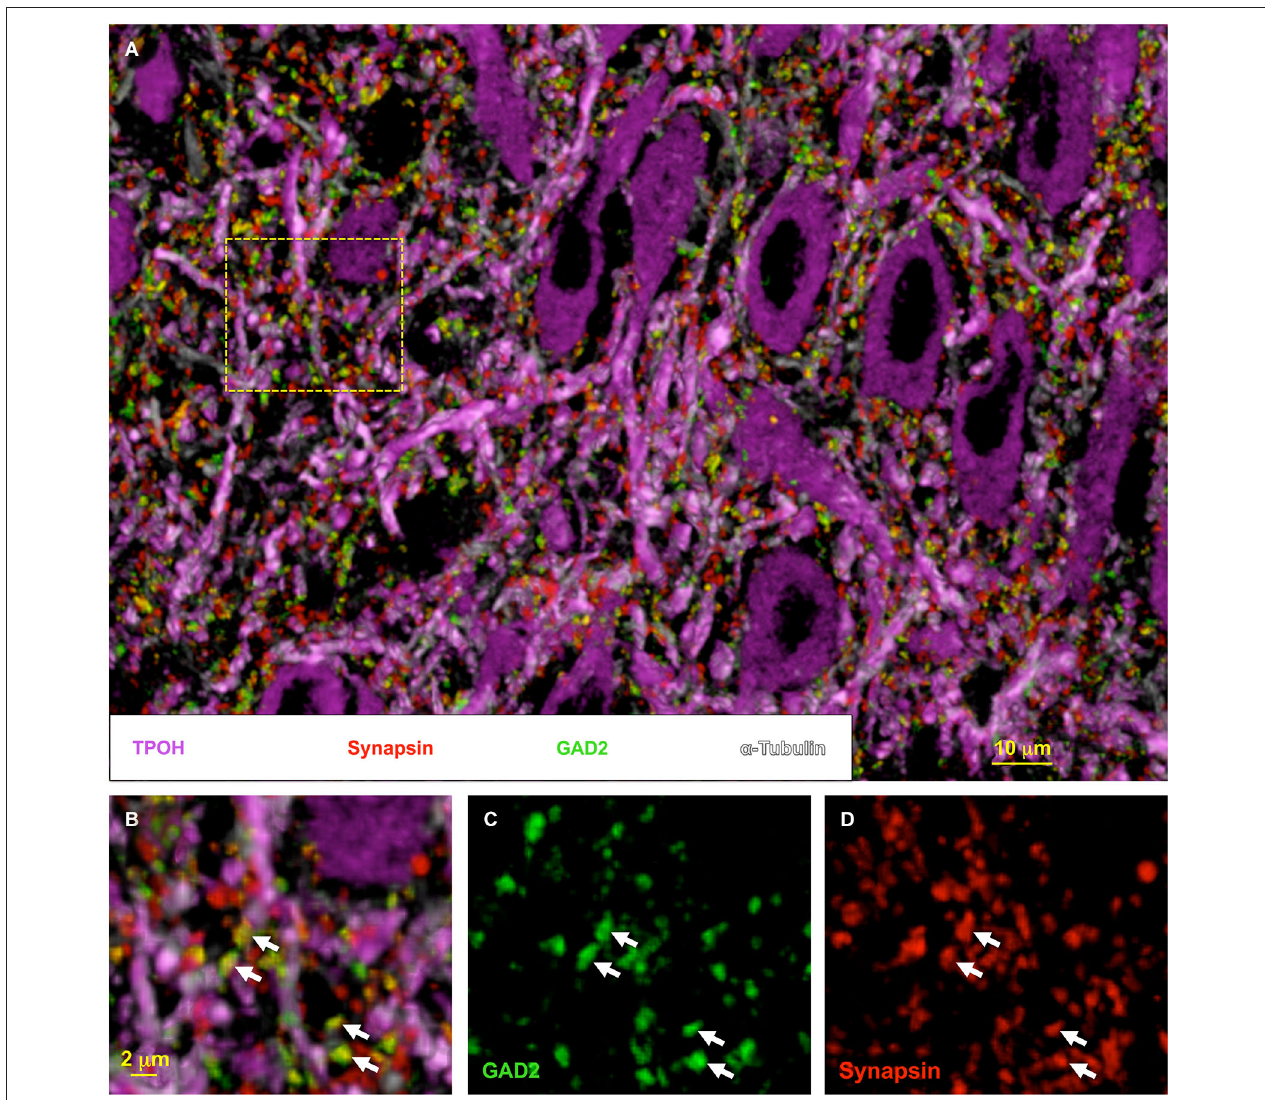
present at the synaptic vesicles (red). A proportion of these axon boutons are co-labeled for the GABA synthetic enzyme glutamate decarboxylase 65 (GAD2) (green) (indicated by the arrows in (B–D) ). However, a large proportion of synaptic boutons do not contain the GABAergic marker, likely representing glutamate and other axonal populations within the DRN. Individually-resolved labeled puncta visualized with AT can be subjected to semi-automatic quantitative analysis using ImageJ software, giving a distribution of multiple populations of synaptic boutons within the same volume of